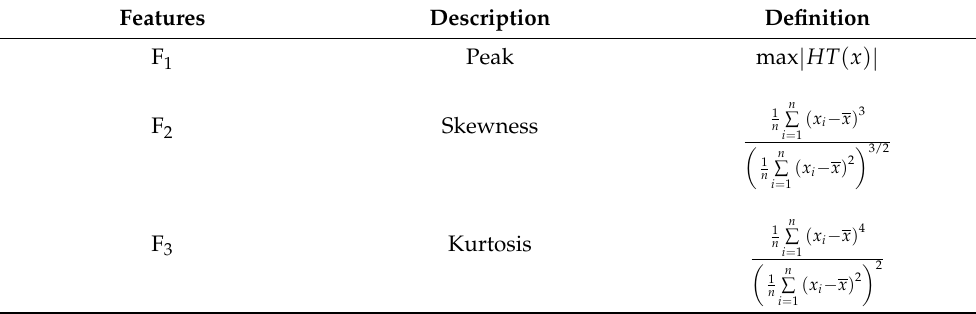
Figure 7. Example of the CWT coefficients: ( a ) CWT coefficients along the time − frequency range and ( b ) CWT coefficients at 0.62 MHz. Table 2. Features extracted from the obtained CWT